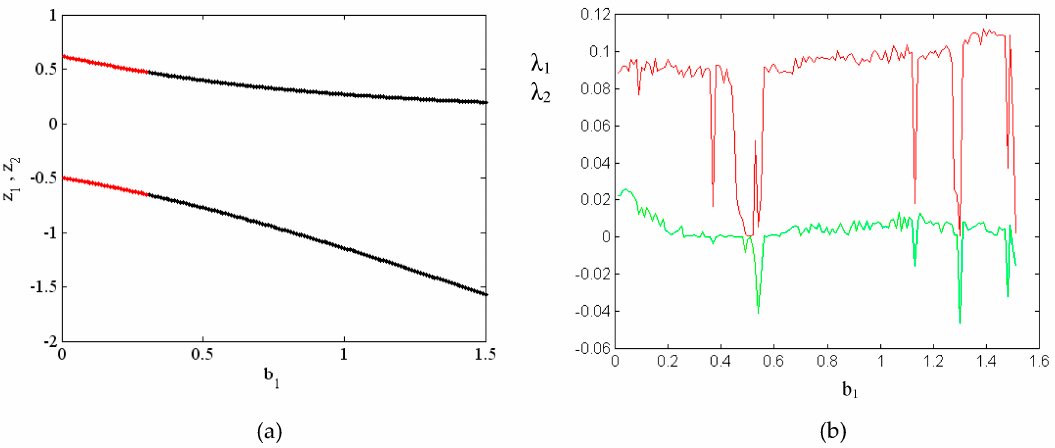
Figure A1. Equilibrium points z 1 , z 2 ( a ) and Lyapunov exponents spectrum ( b ) when b 2 = − 0.1, b 3 = b 4 = 0.1 and b 1 ∈ [ 0.01, 1.5 ] . All other parameter values are same as those in original Rössler hyperchaotic system; see [11]. Note that red color (see ( a )) marks those equilibria for which the system (2) exhibits hyperchaotic behavior.